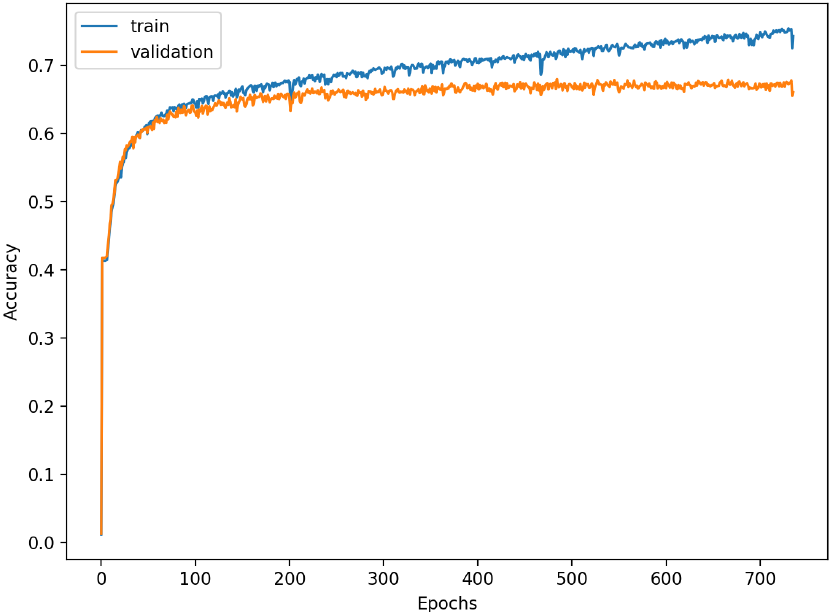
Figure 20. Learning process of the Neural Network for softmax-based classification (20